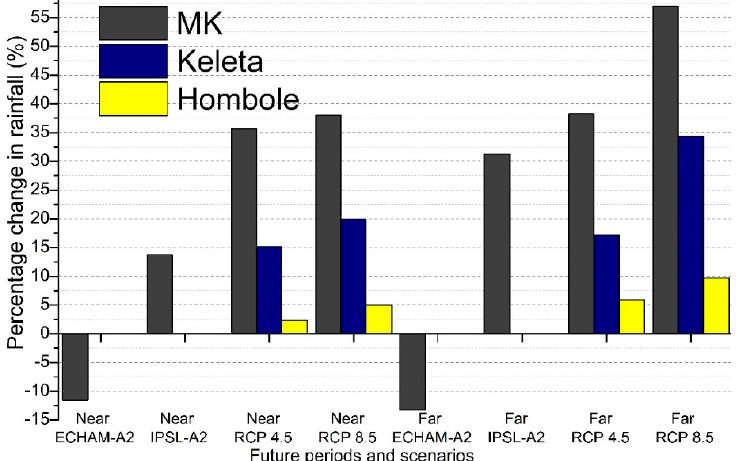
Figure 17. Comparison of projected percentages changes in rainfall (%) in the MK, the Keleta and the Hombole subbasins.